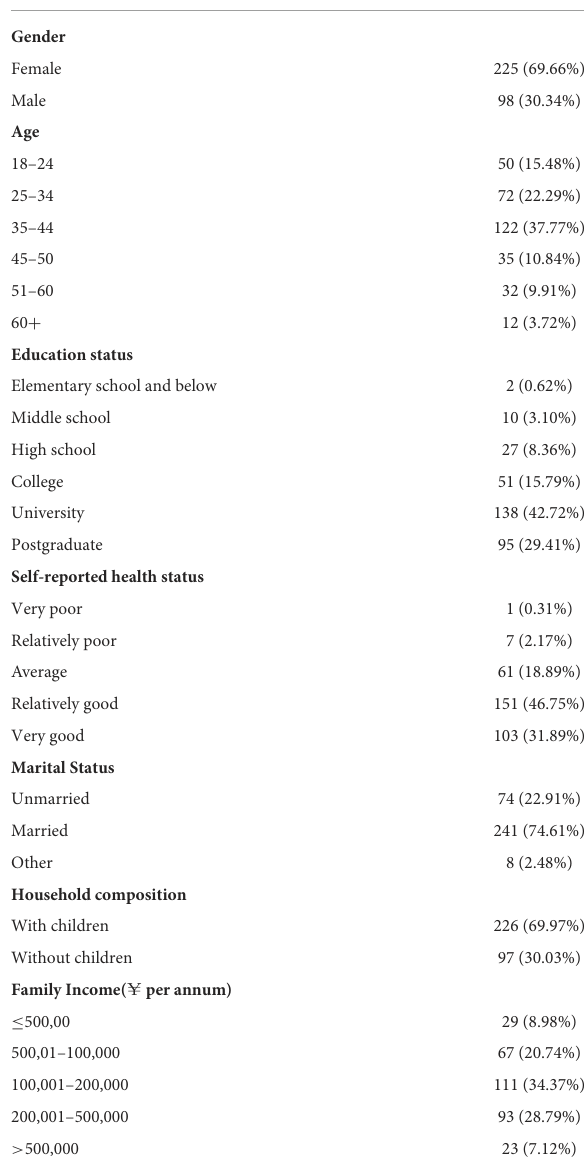
TABLE 2 Sociodemographic characteristics of the study